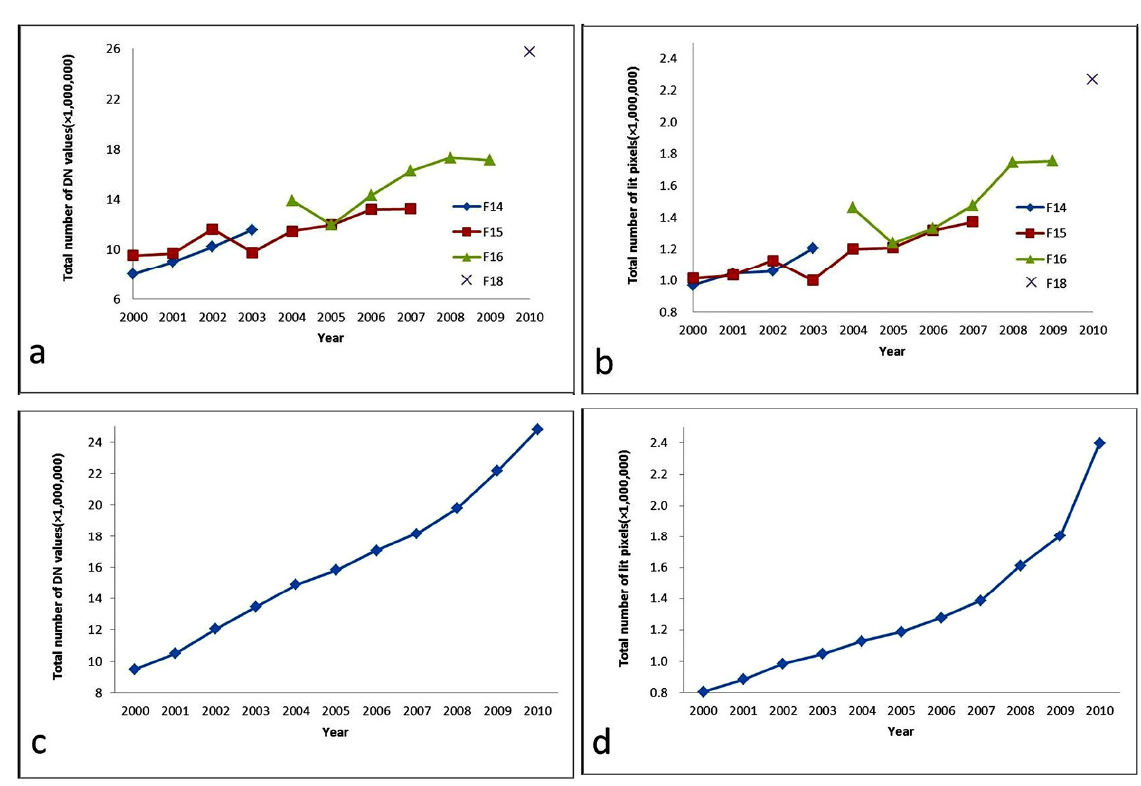
Figure 4. Basic statistics of the NTL China data between 2000 and 2010, with ( a , b ) before calibration; ( c , d ) after